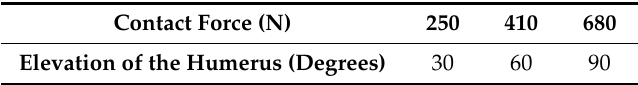
Table 4. The applied force to the glenosphere as a function of the elevation angle of the humerus in the case of individual 3.